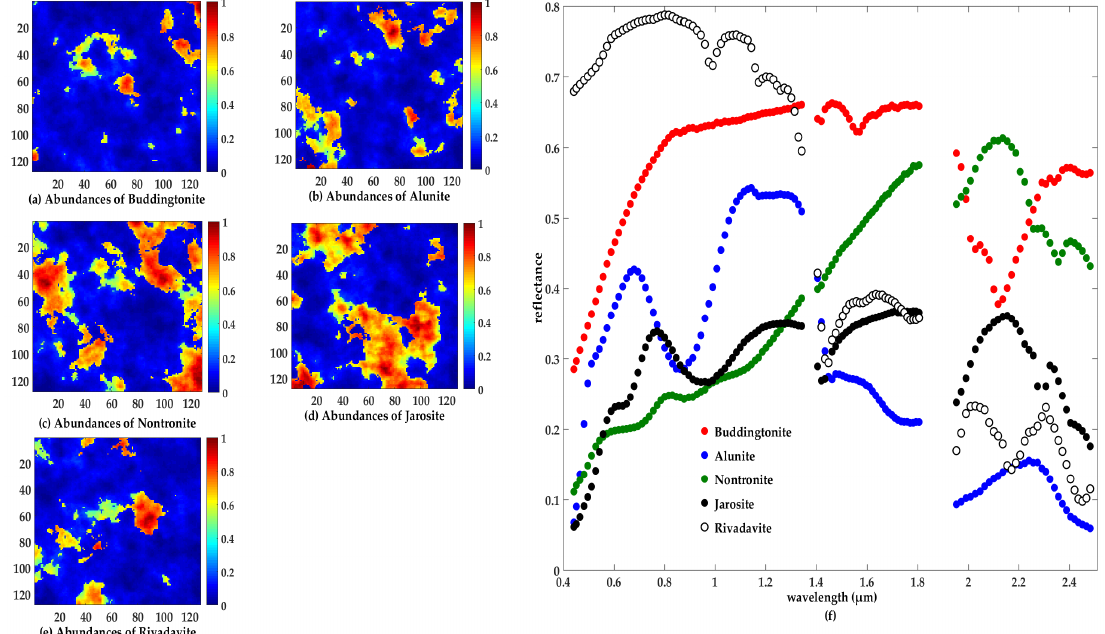
Figure 4. blueTrue fractional abundances of the materials used to generate a geological dataset with spectrally distinct materials: ( a ) Buddingtonite; ( b ) Alunite; ( c ) Montmorillonite; ( d ) Jarosite; and ( e ) Rivadavite; and their spectral profiles ( f